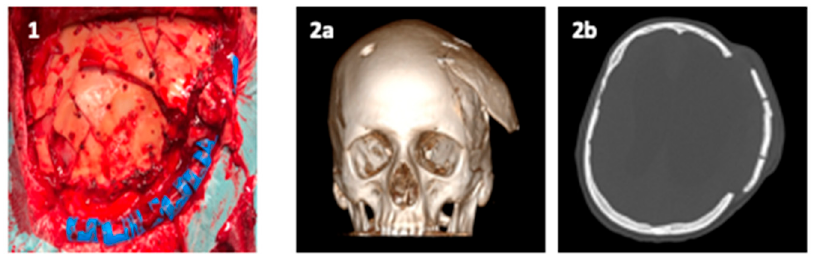
Figure 5. ( 1 ) PMMA cranioplasty fractures; ( 2a ) 3D and ( 2b ) axial CT-scan of PMMA cranioplasty displacement.